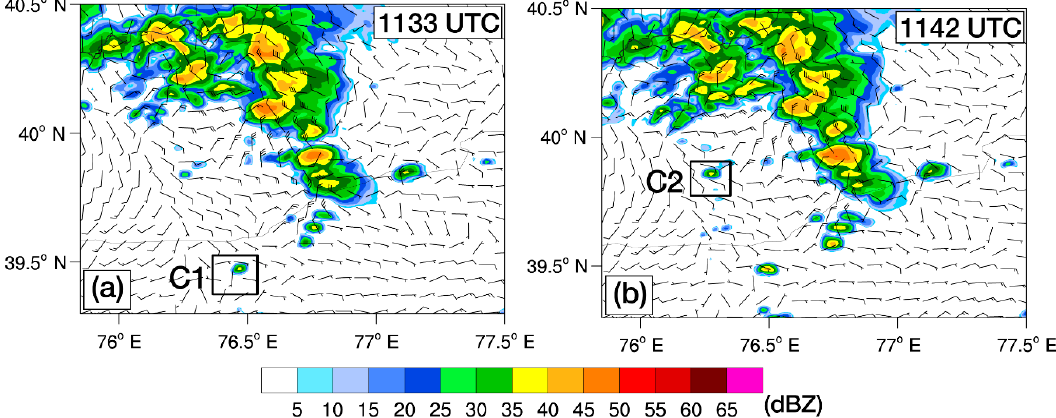
Figure 8. ( a ) Simulated composite reflectivity (shading; unit: dBZ) and ground relative wind field (full and half barbs represent 4 and 2 m · s − 1 , respectively) at the height of 10 m above the ground level on 23 June 2015 for C1. ( b ) is the same as ( a ) but for the C2. The black boxes in both panels denote the area where the two convective cells occurred for the first time. The specific time is shown in the upper right corner of each panel.